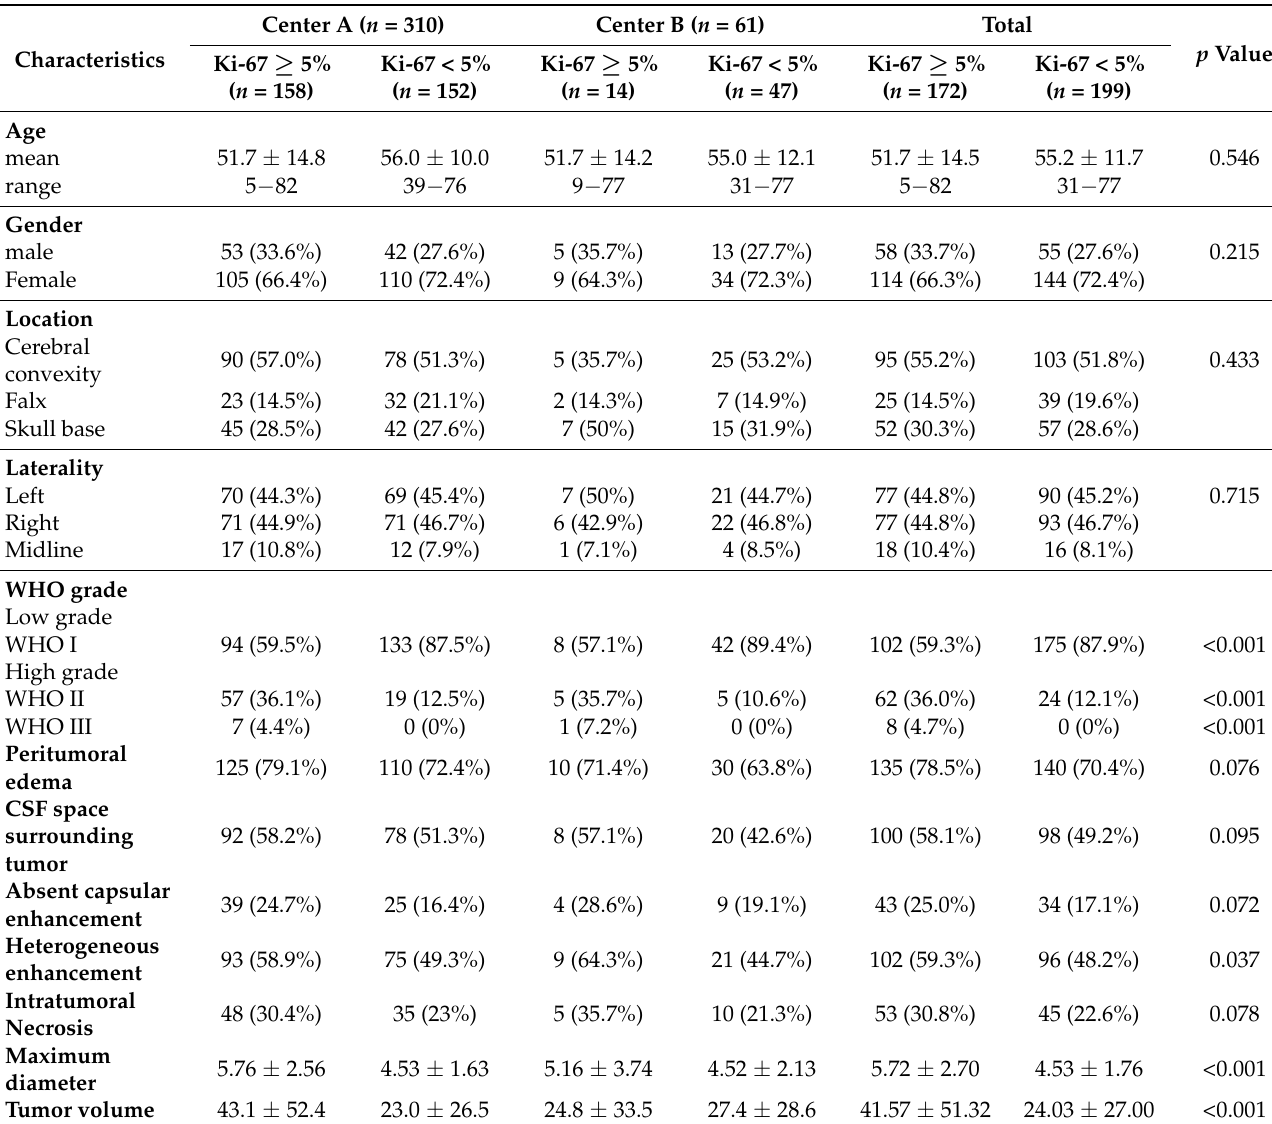
Table 1. Baseline clinical and radiological characteristics of the study